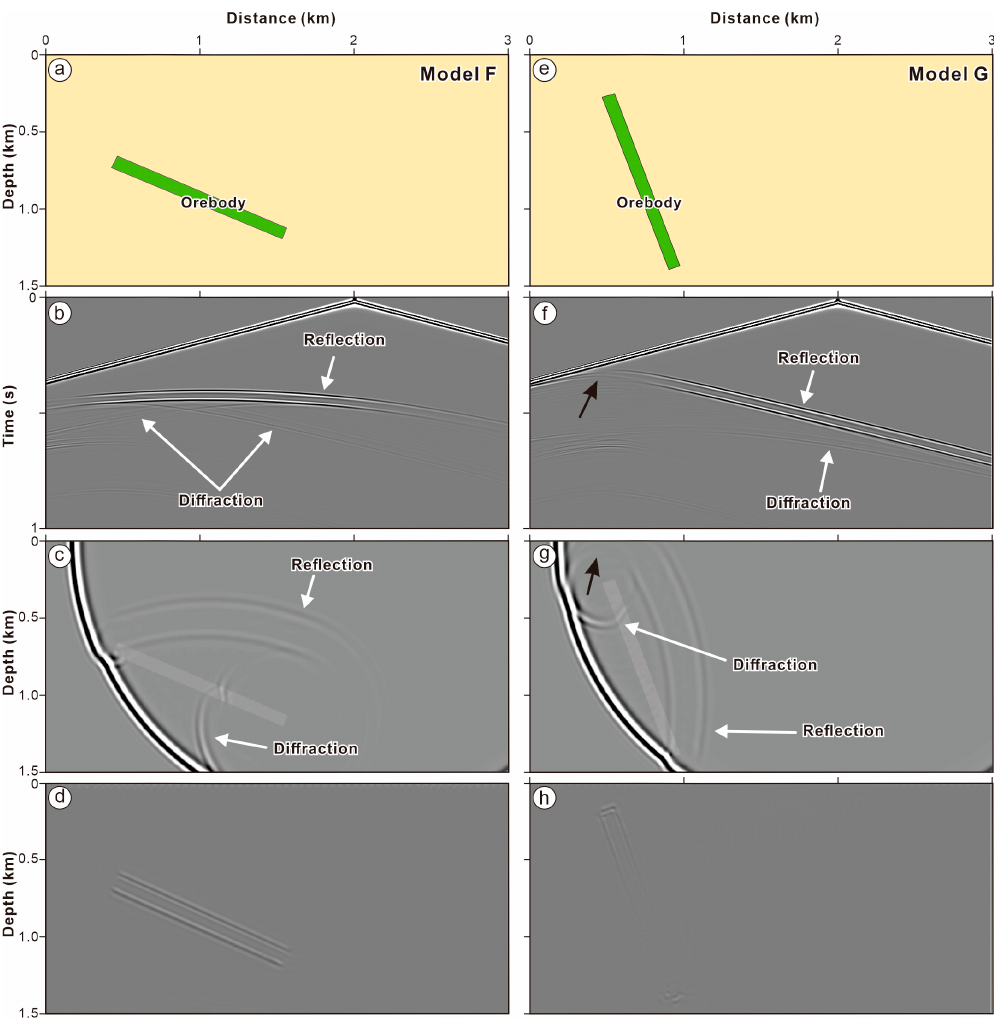
Figure 4. Geological profiles ( a , e ), synthetic seismograms ( b , f ), snapshots ( c , g ), and RTM imaging results ( d , h ) of models F and G. Black arrows indicate the relatively weak reflected signals above the steeply dipping target. See rock properties in Table 3.